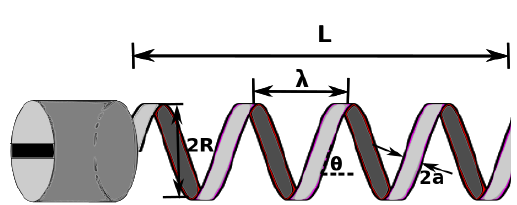
Figure 1. Helical microswimmer